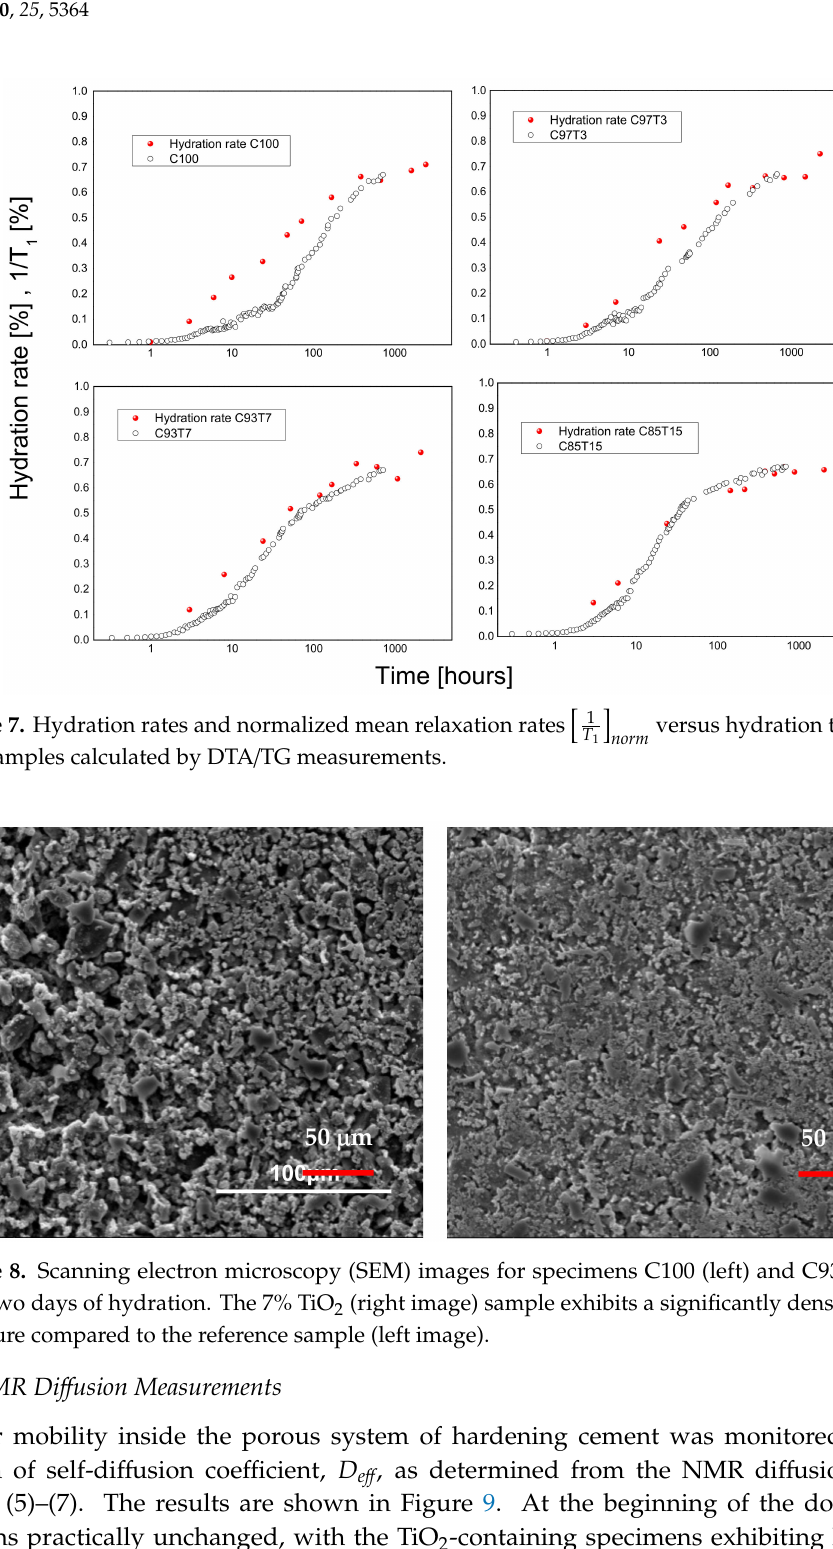
Figure 8. Scanning electron microscopy (SEM) images for specimens C100 (left) and C93T7 (right) after two days of hydration. The 7% TiO 2 (right image) sample exhibits a significantly denser internal structure compared to the reference sample (left